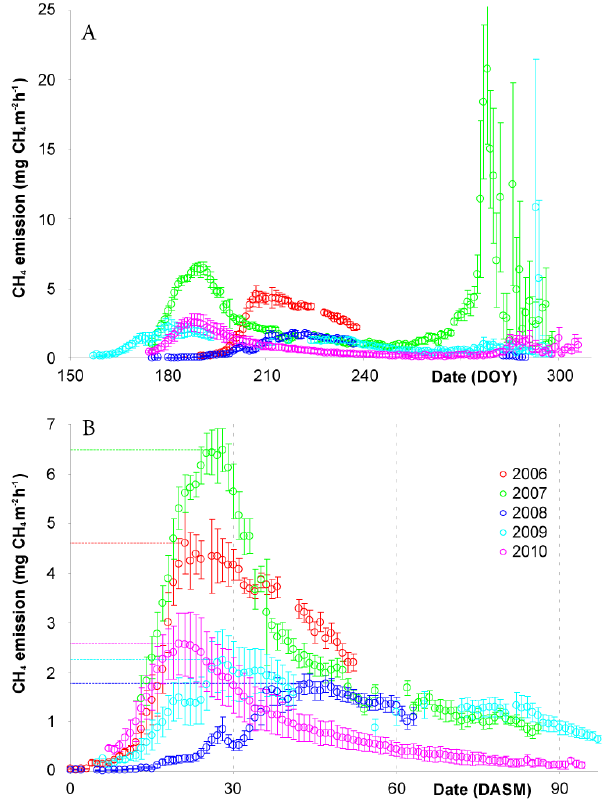
Fig. 3. Soil thaw dynamics. A , B soil thaw depth (relative to the sur- face); C frozen table depth relative to the reference level. A , C nor- malized to day of year (DOY); B normalized to day after snowmelt (DASM).